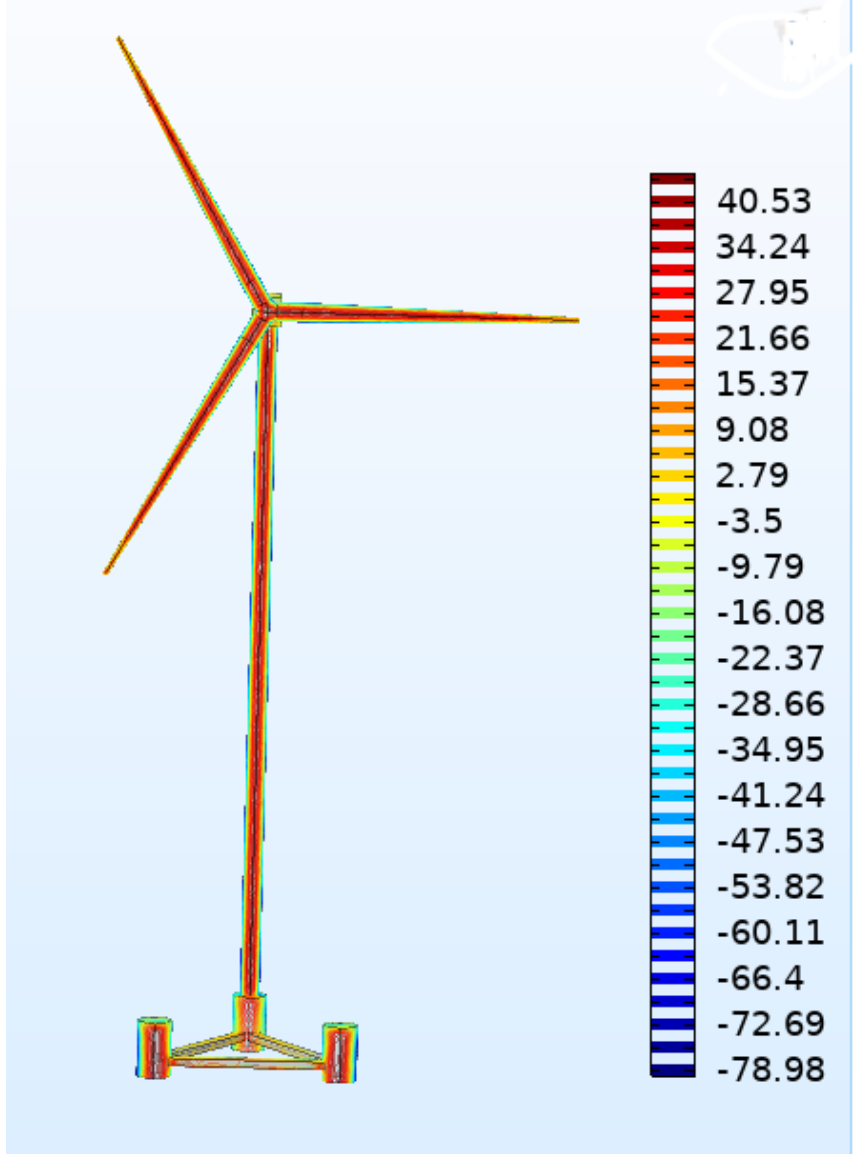
Figure 12. Pressure (Pa) using the